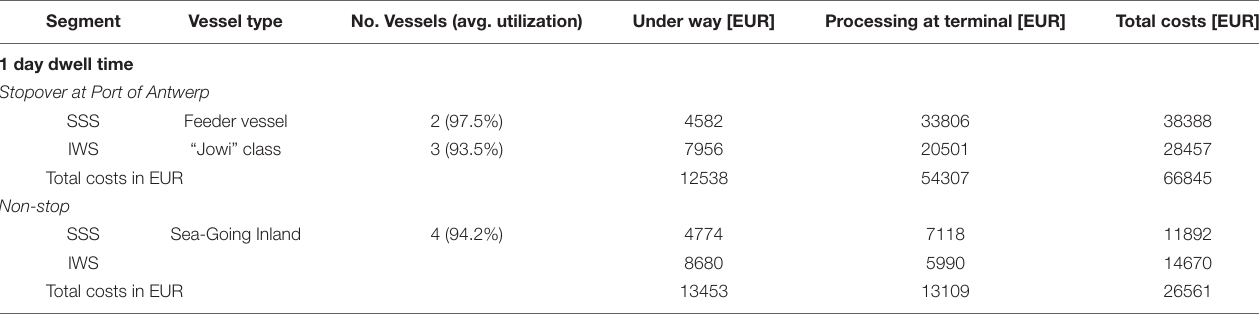
TABLE 9 | Breakdown of costs per deployed vessel type and mode of operation in EUR on a round trip between transport and logistics hub and NRW with stopover at the Port of Antwerp and with a non-stop solution, adapted from (Assbrock et al., 2020). Segment